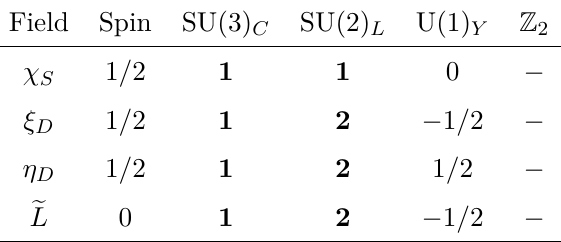
Table 1. New particles and their quantum numbers in Model